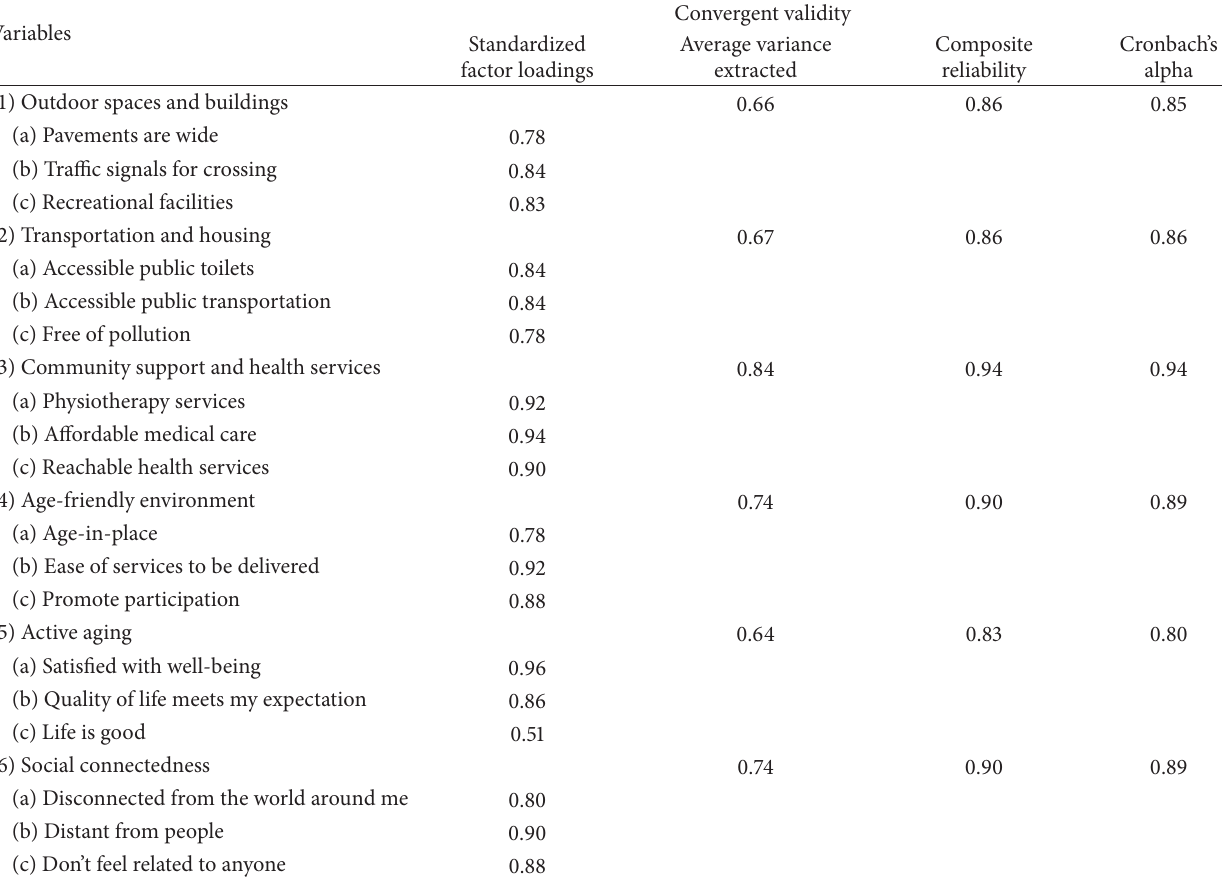
Table 4: Analysis of convergent validity of integrated model of age-friendly environment, active aging, and social connectedness. Variables